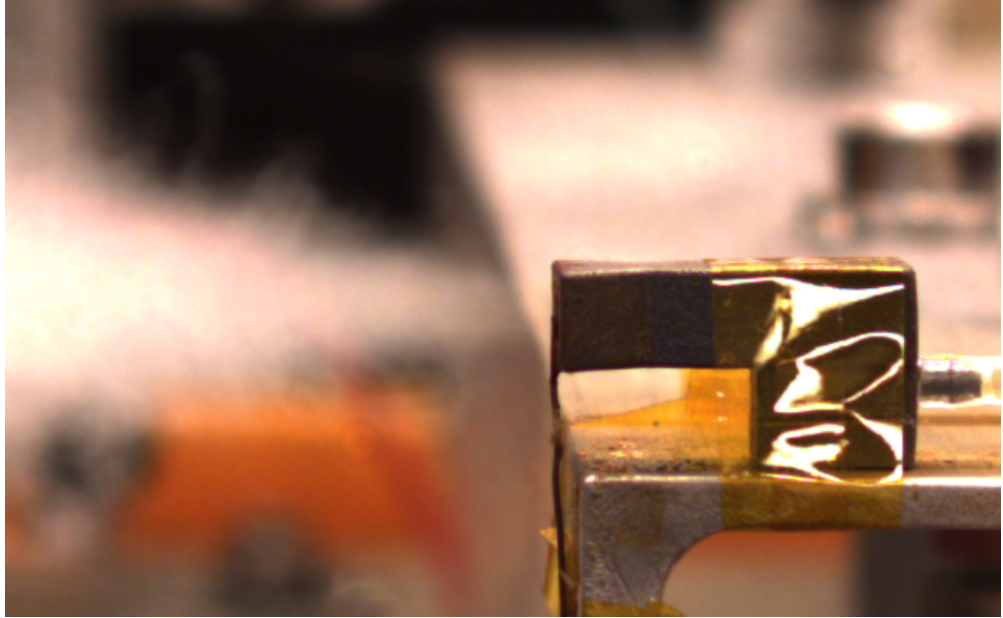
Figure 17. A photograph of the thruster system operating during the plume temperature measurement experiment. Condensation surrounding the plume is